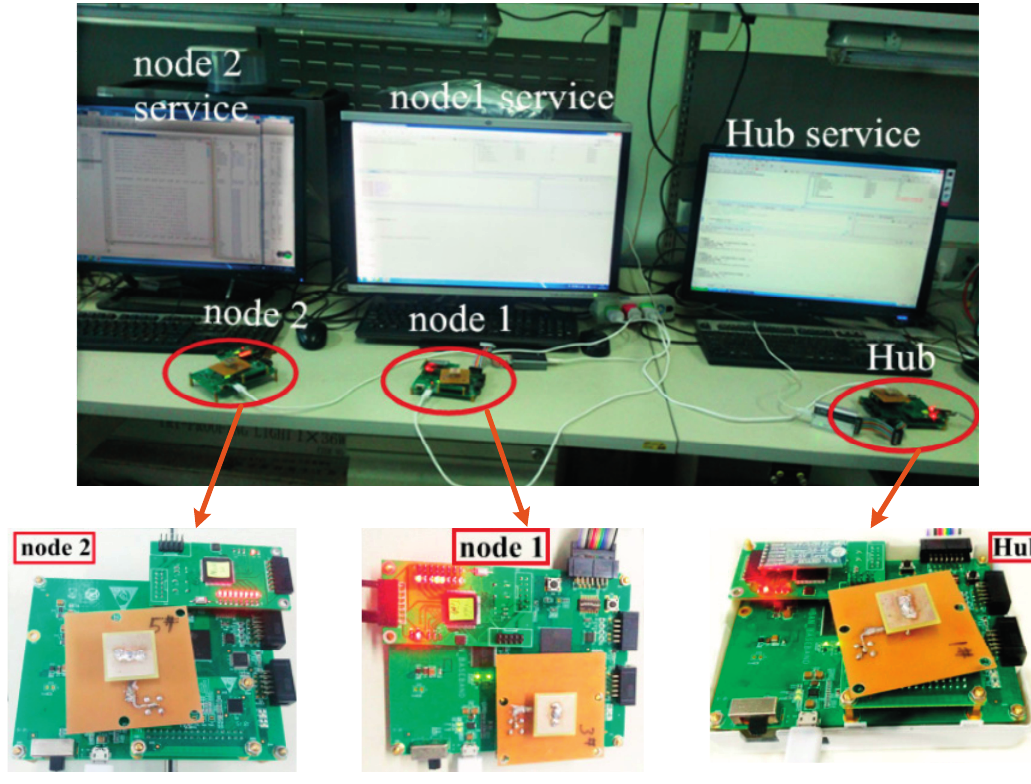
Figure 19. An experiment scenario of WBAN with three